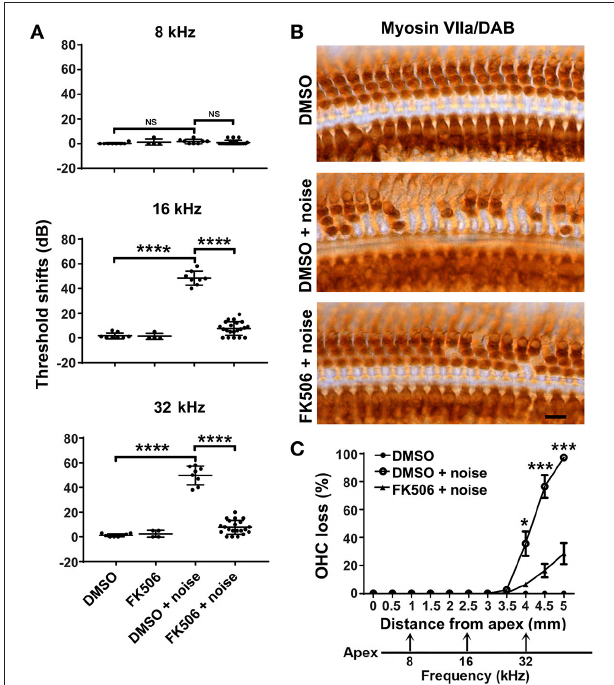
FIGURE 2 | Treatment with FK506 prevents noise-induced outer hair cell (OHC) loss and hearing loss. (A) Treatment with FK506 significantly attenuates noise-induced auditory threshold shifts at 16 and 32kHz measured 14 days after exposure. FK506 alone and vehicle control (dimethyl sulfoxide, DMSO) alone do not alter auditory threshold shifts. Data are presented as individual points measured in the left ears with means ± SD for each group; **** p < 0.0001; ns, not significant. (B) Representative images show Myosin-VIIa-labeled and 3,3 ′ -diaminobenzidine-stained surface preparations from three groups: DMSO without noise, DMSO + noise, and FK506 + noise. Images were taken from the basal turn around 4.5mm from the apex. Scale bar = 10 µ m. (C) The percentage of cochlear OHC loss assessed 14 days after noise exposure, with OHC loss beginning around 3.5mm from the apex and increasing until reaching 100% OHC loss in the basal region (5mm from the apex). Treatment with FK506 significantly reduced noise-induced OHC loss. DMSO alone without noise exposure had no effect on hair cell loss. The distances along the cochlear spiral correlating with the frequencies 8, 16, and 32kHz are indicated. Data are presented as means ± SEM for the left ears; DMSO only: n = 6, DMSO + noise: n = 9, FK506 + noise: n = 6; * p < 0.05, *** p < 0.0001.